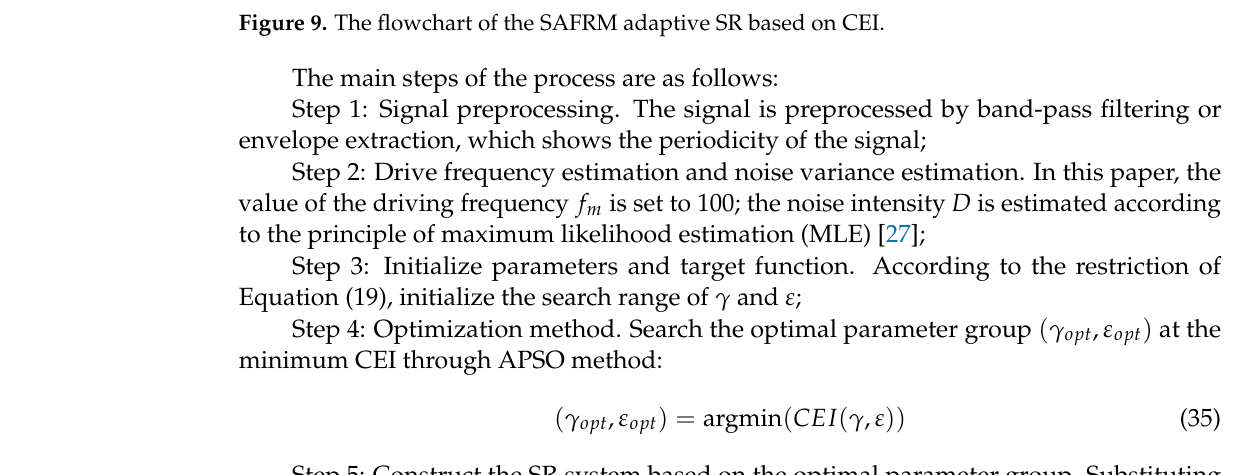
Figure 9. The flowchart of the SAFRM adaptive SR based on CEI.